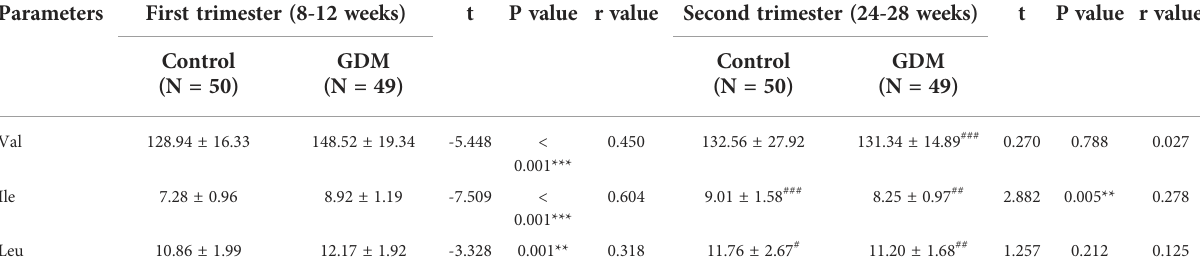
TABLE 3 The serum levels of branched-chain amino acids (BCAAs) in patients with gestational diabetes mellitus (GDM) and controls.